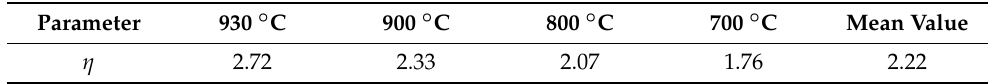
Figure 7. Relationship between Table 5. Calculated results for η